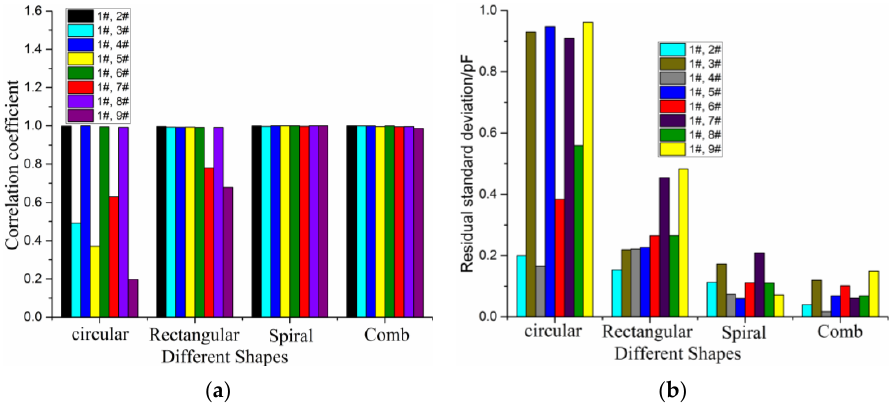
Figure 8. Correlation coefficient ( a ) and residual standard deviation ( b ) between 1# sensitivity position with others sensitivity positions, respectively, for the four electrode shapes.